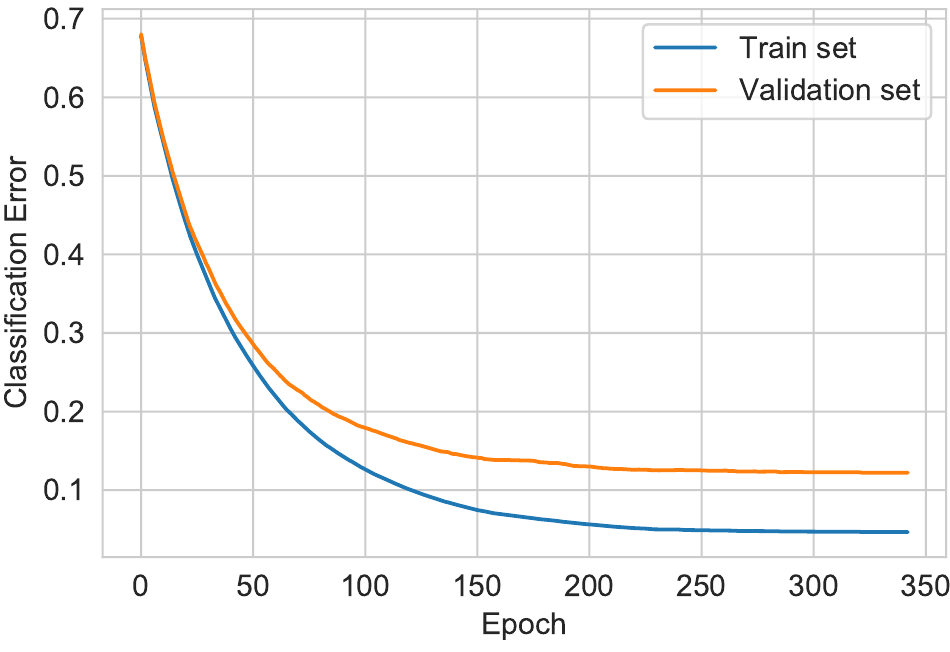
Figure 10. XGBoost learning